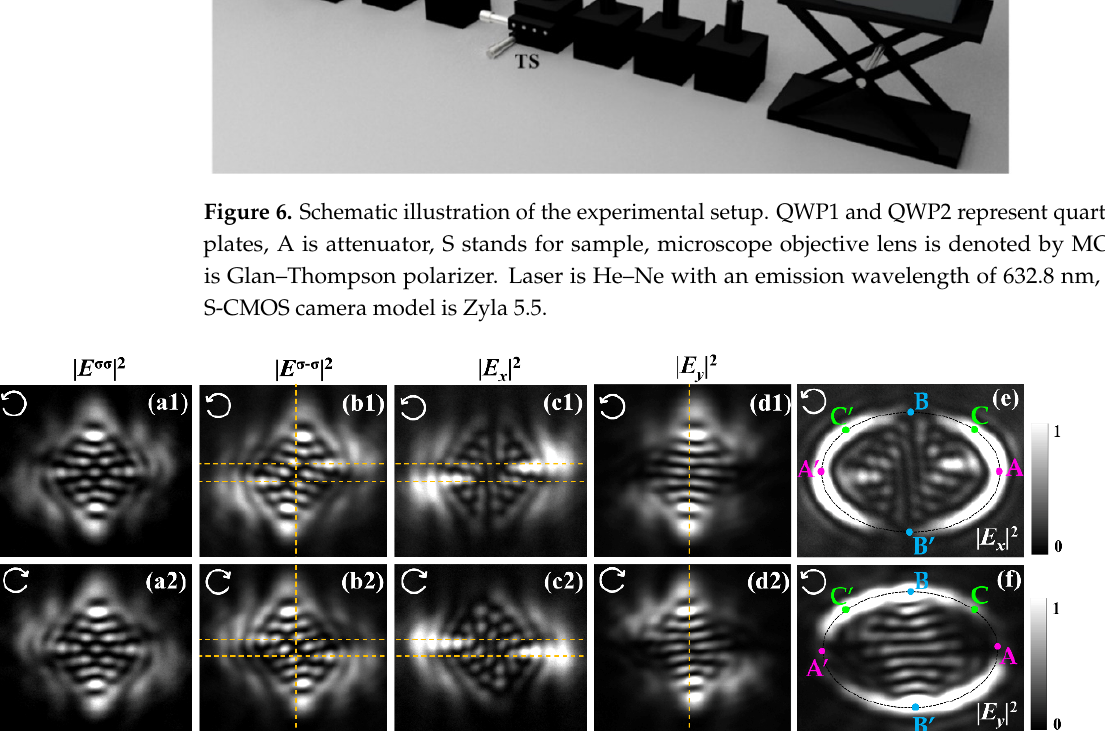
Figure 6. Schematic illustration of the experimental setup. QWP1 and QWP2 represent quarter- wave plates, A is attenuator, S stands for sample, microscope objective lens is denoted by MO, and